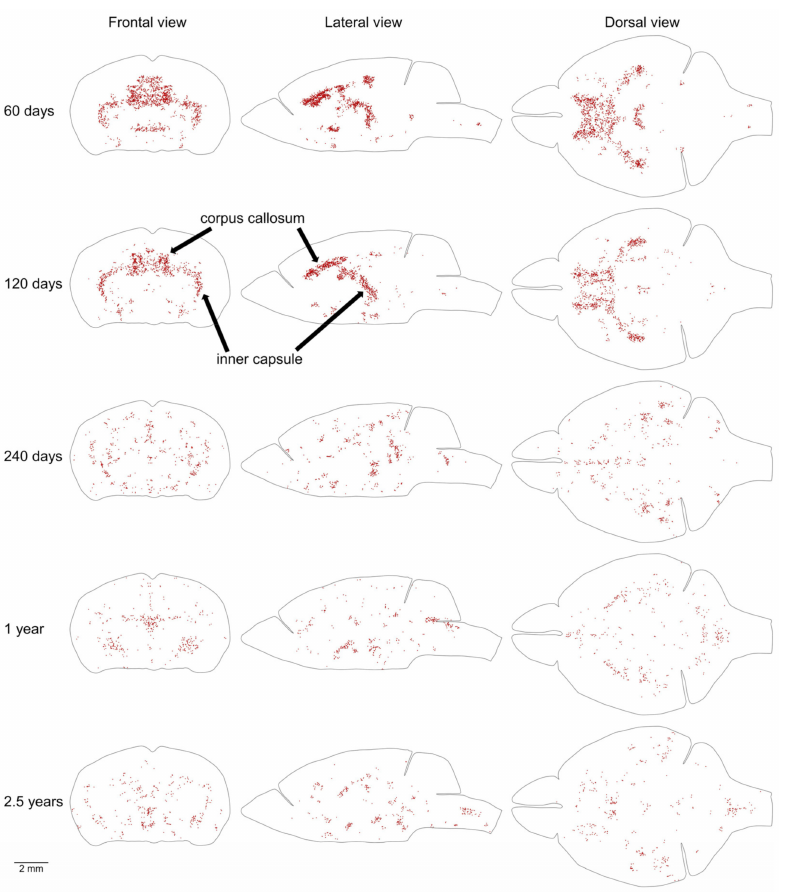
Figure 7. Distribution of proliferating cells in areas with the highest density of proliferating cells outside of the MPZ and SGZ. The distribution of 20% of cells located outside of the MPZ and SGZ that have the highest volume number density is shown. To exclude cells located in the random aggregations of proliferating cells we show only cells in the areas with higher density on both sides of the brain. Each EdU-labeled nucleus is shown as a red dot. The brain shape is outlined with a black line. Frontal, lateral, and dorsal views of the brain are shown. Mouse age is shown on the left. The size scale is shown at the